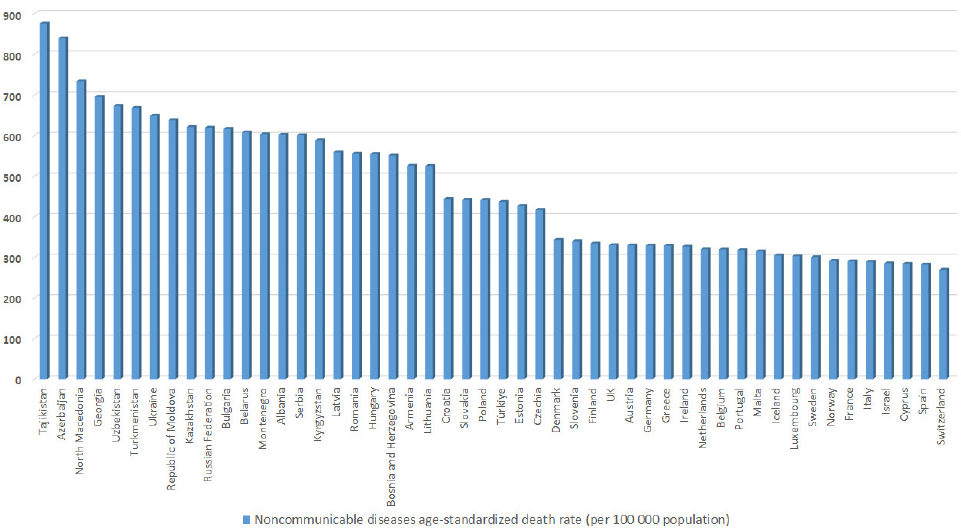
Figure 1. Noncommunicable diseases age-standardized death rates (per 100,000 population) in Europe in 2019. [2].